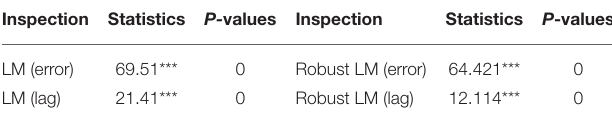
TABLE 4 | Model test of spatial econometric